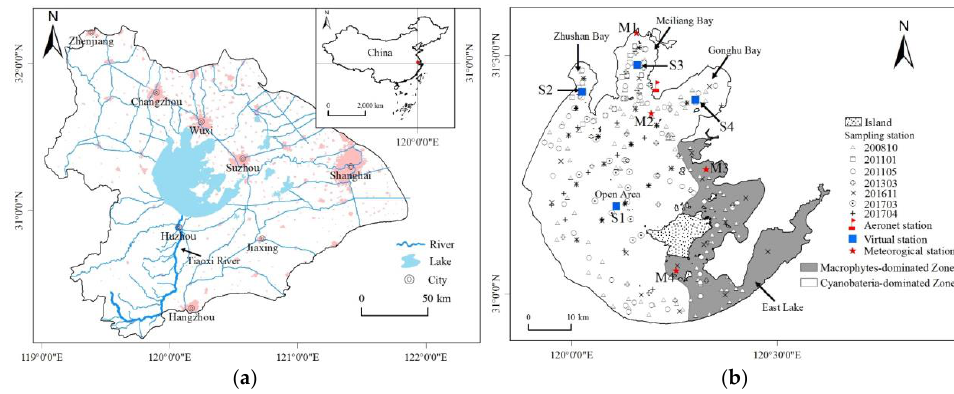
Figure 1. Location of Lake Taihu, China. ( a ) The Lake Taihu Basin is a flat region, and the Tiaoxi River (denoted by the black arrow) exhibits the maximum inflow; ( b ) following convention, the lake is divided into several segments. The black symbols with different shapes indicate sampling stations during seven cruise surveys in October 2008, January 2011, May 2011, March 2013, November 2016, March 2017, and April 2017. The red flag is the AERONET station, and the red stars are meteorological stations. The blue squares indicate four virtual stations located in different lake segments.